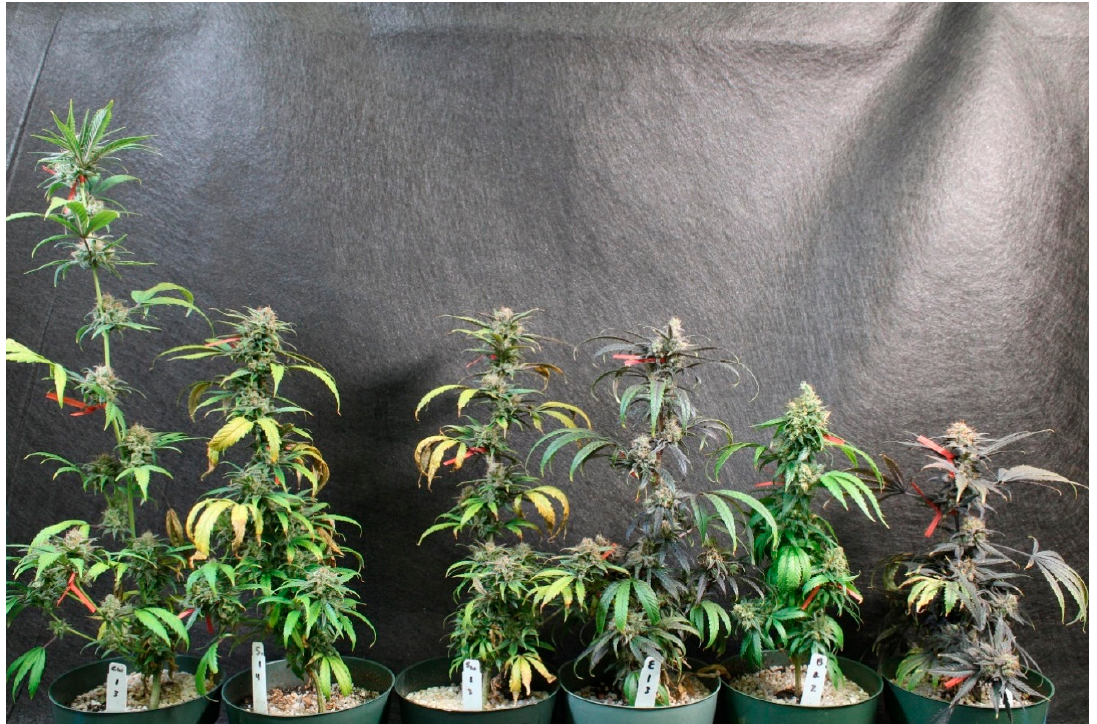
Figure 5. Six C. sativa plants of di ff erent cultivars (left to right: “Cherry Wine”, “Stout”, “Sweetened”, “Ethephon”, “BaOx”, and “Suver Haze”) exhibiting di ff erences in flowering shape, plant architecture, and branching after eight weeks of flowering stage growth under short day conditions.